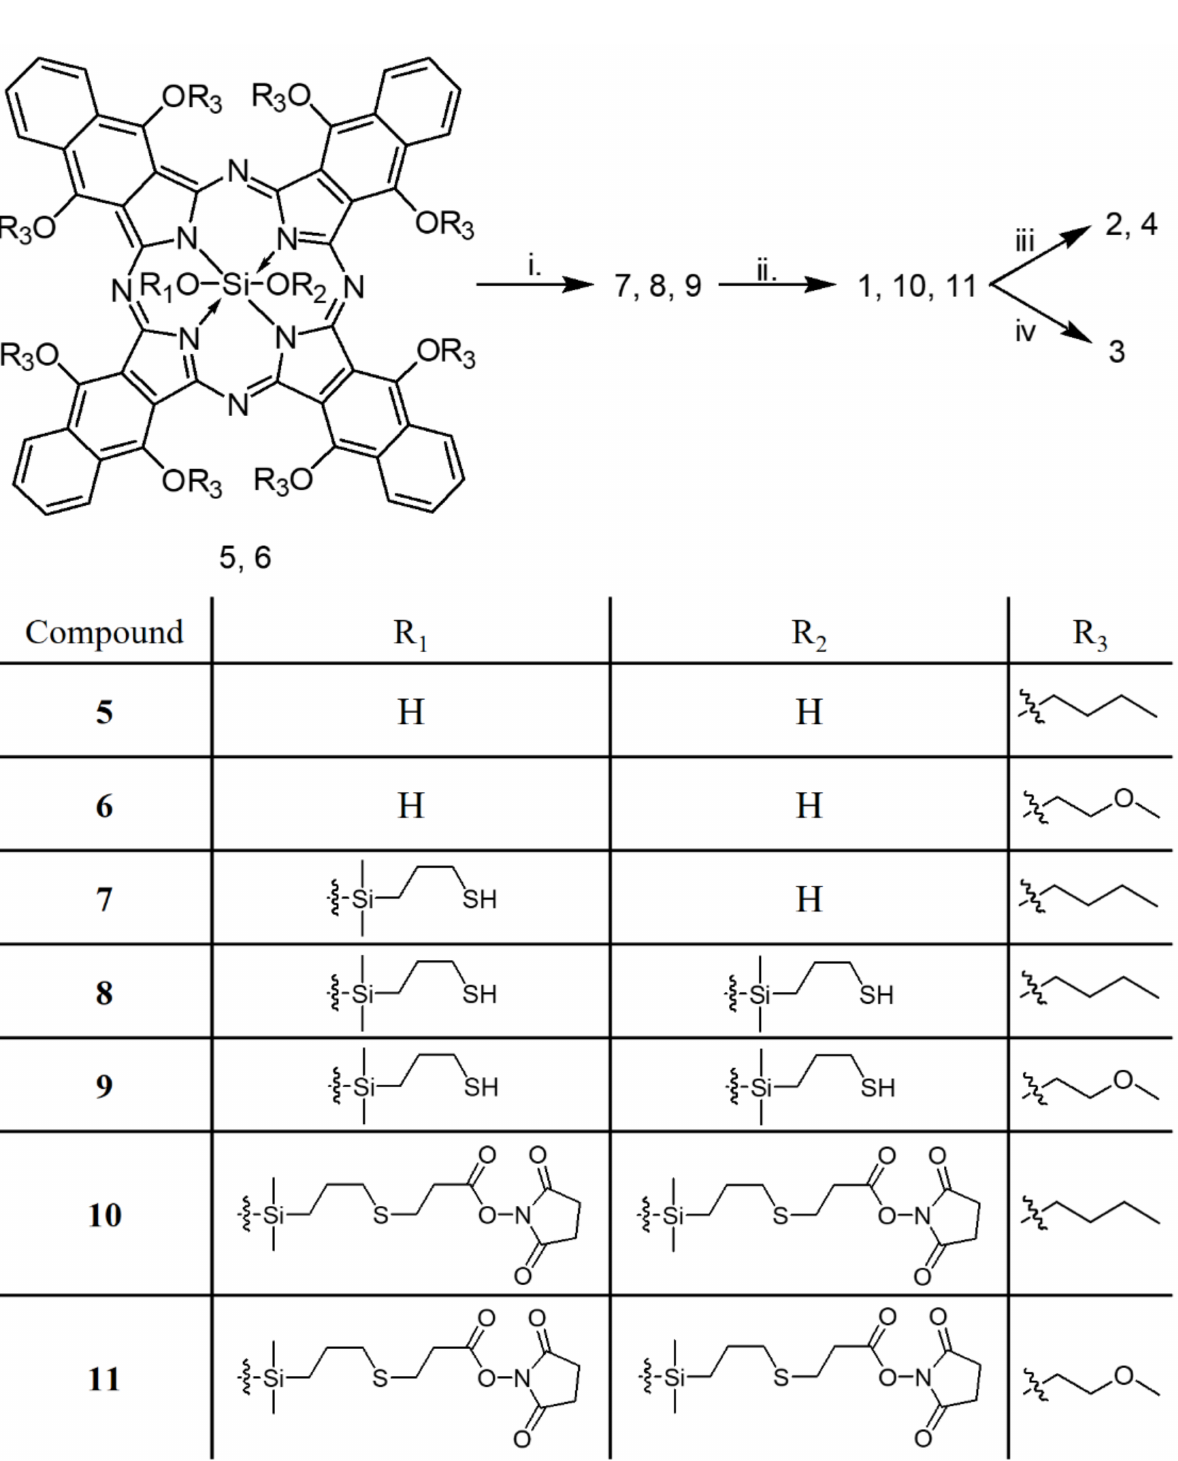
Scheme 1. Synthesis of silicon naphthalocyanine dyes 1–4 (SiNC(1–4)). ( i ). Methoxydimethylsi- lylpropanethiol, pyridine, 130–140 ◦ C, 16 h. ( ii ). N-succinimidyl acrylate, diisopropylethylamine, dichloromethane, 40 ◦ C, 16 h. ( iii ). A. Bis(N,N-dimethylaminopropyl)amine, chloroform, 16 h. b. Methyl methane sulfonate, 16 h. ( iv ). A. Bis(N,N-dimethylaminopropyl)amine, chloroform, 16 h. b. 2,(2-(2-methoxyethoxy))ethoxy)ethoxy mesylate, chloroform, 72